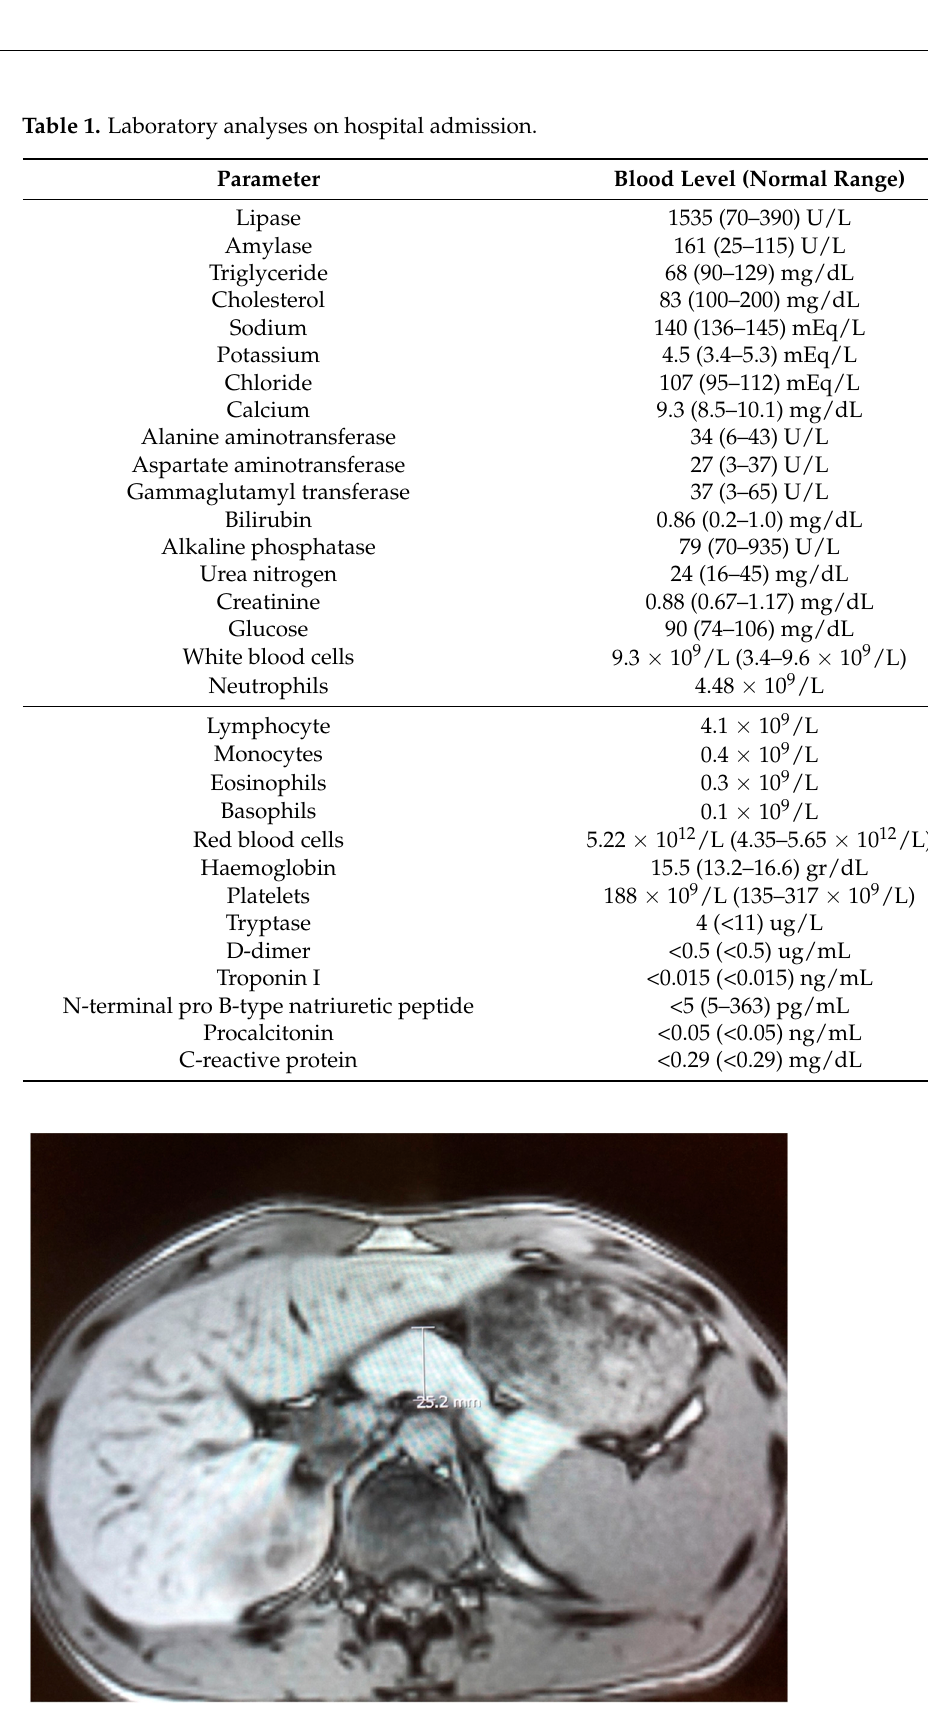
Figure 1. Abdominal magnetic resonance imaging showing enlargement of the pancreatic gland and an increase in its intensity.